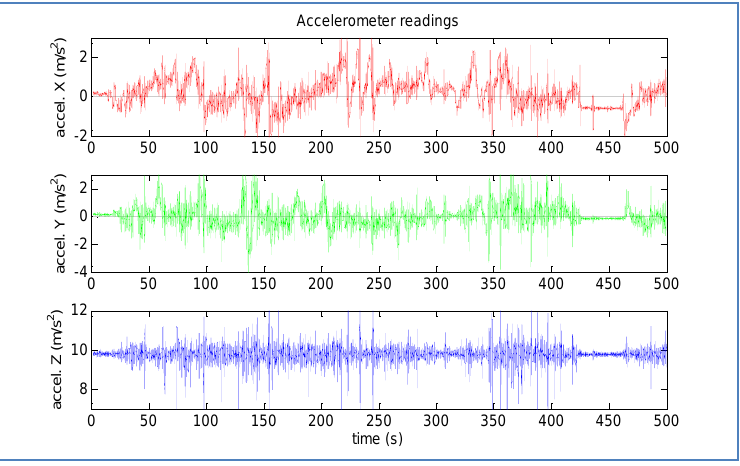
Figure 9. Sample accelerometer readings featuring two stops around t = [0;15] and t = [430;460] seconds. The varying bias during stops makes the raw signal not adequate for detecting